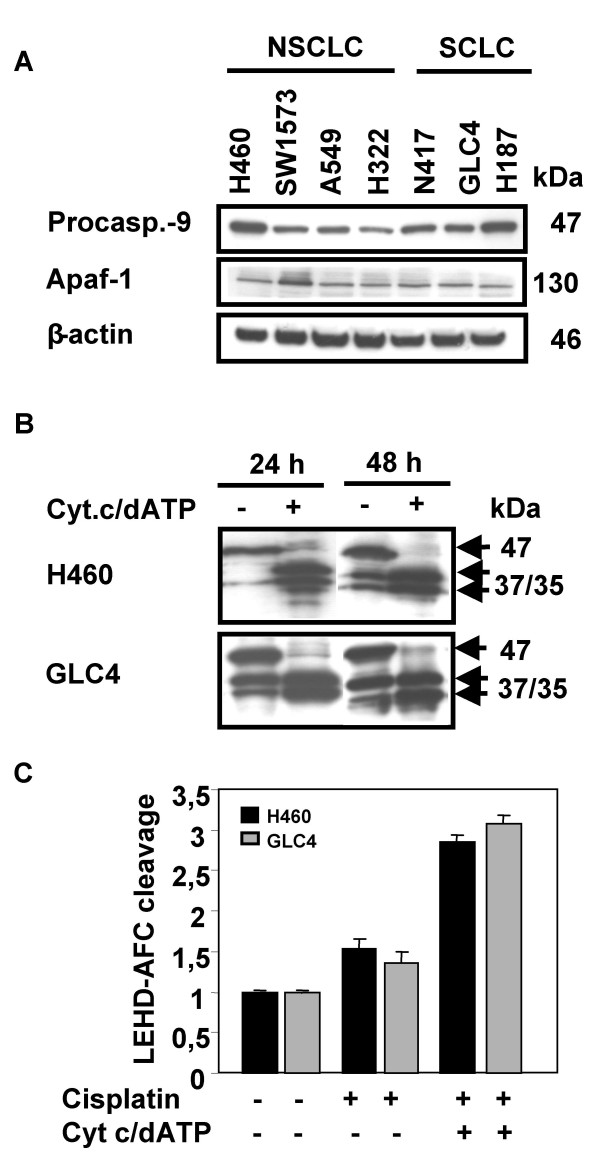
Caspase-9 expression and processing in NSCLC and SCLC cell line. A) Western blots showing the level of expression of procaspase-9 and Apaf-1 in a panel of NSCLC and SCLC cell lines. β-actin was used as control for protein loading. B) H460 and GLC4 cells were treated with IC80 concentrations of cisplatin for 24 and 48 h or C) only for 48 h and cellular extracts were generated. Extracts were incubated for 45 min at 37°C in the presence (+) or absence (-) of exogenously added cytochrome c and dATP. Subsequently, caspase-9 was immunoprecipitated and visualized by western blotting or activation of caspase-9 was measured by the cleavage of the fluorogenic substrate LEHD-AFC, respectively.